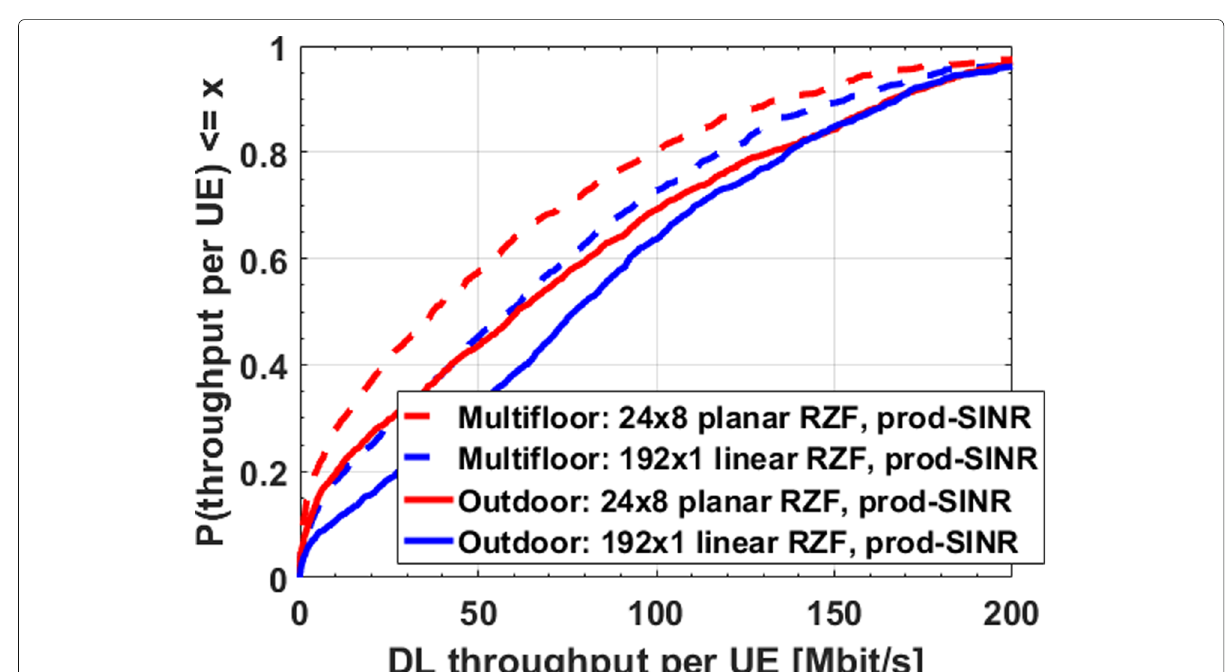
Fig. 12 DL throughput per UE between two different user distributions utilizing the identical antenna arrays at the BS